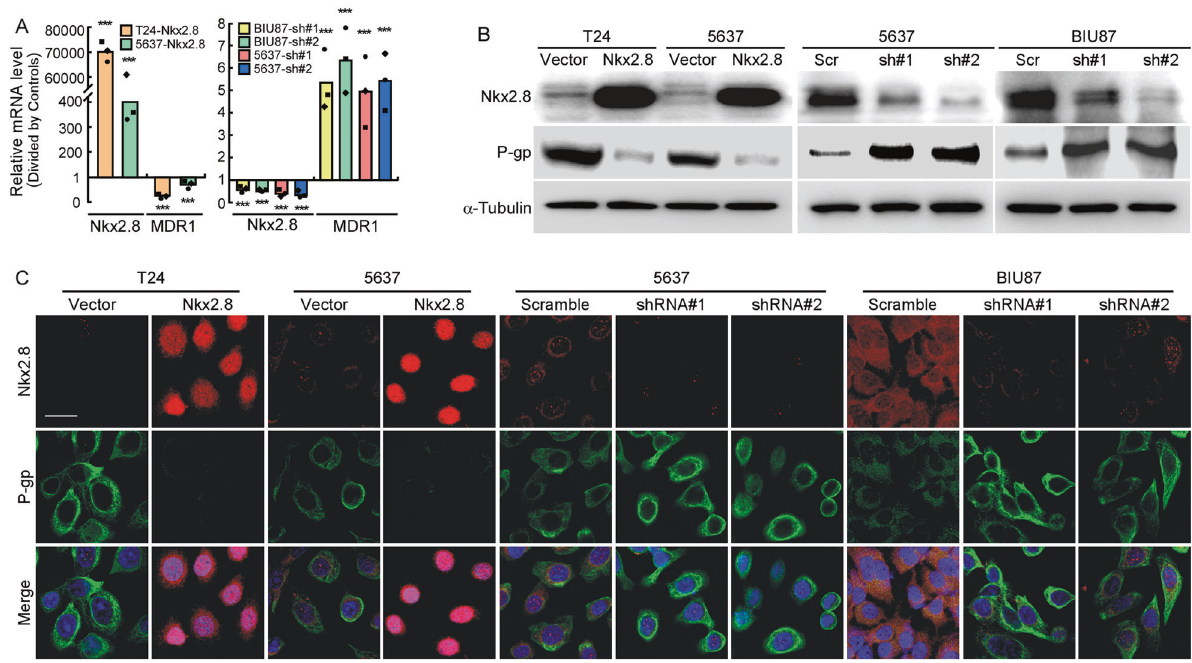
Fig. 4 Nkx2.8 represses MDR1 expression in UC cells. A Real-time PCR analysis of Nkx2.8 and MDR1 mRNA expression in T24 and 5637 with vector or Nkx2.8 overexpressed (left panel) or 5637 and BIU87 with scramble or Nkx2.8 knocking-down (right panel). Transcript levels were normalized to GAPDH (mean ± SD). *** p < 0.0001 (two-tailed t test, n = 3). B Western blot analysis of Nkx2.8 and P-gp expression in the indicated cells, α -Tubulin was used as a loading control. C Immuno fl uorescence analysis of Nkx2.8 and P-gp expression in indicated cells. The blue signal signi fi es nuclear DNA staining with DAPI. Scale bar, 20 μ